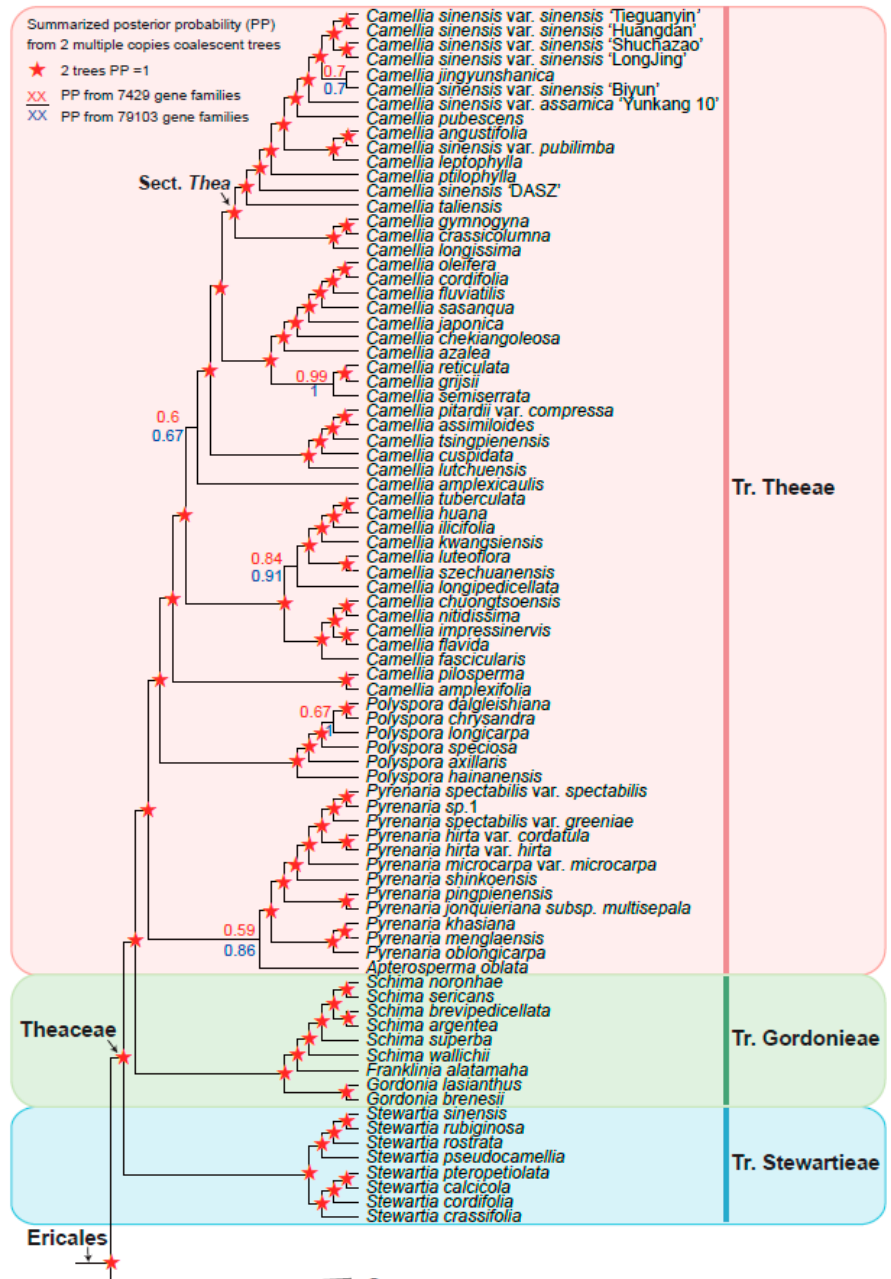
Figure 5. Summarized Theaceae phylogenetic relationships from two multi-copy coalescent trees by ASTRAL-Pro. Red pentagrams indicate maximal posterior probability (PP = 1) in two analyses. For nodes of other types, the node labels above (red) and below (blue) the branch are from 7429 and 79,103 gene families, respectively. The pink, green, and blue vertical line on the right indicate Tr. Theeae, Tr. Gordonieae, and Tr. Stewartieae, respectively. The outgroups collapsed into a black triangle.